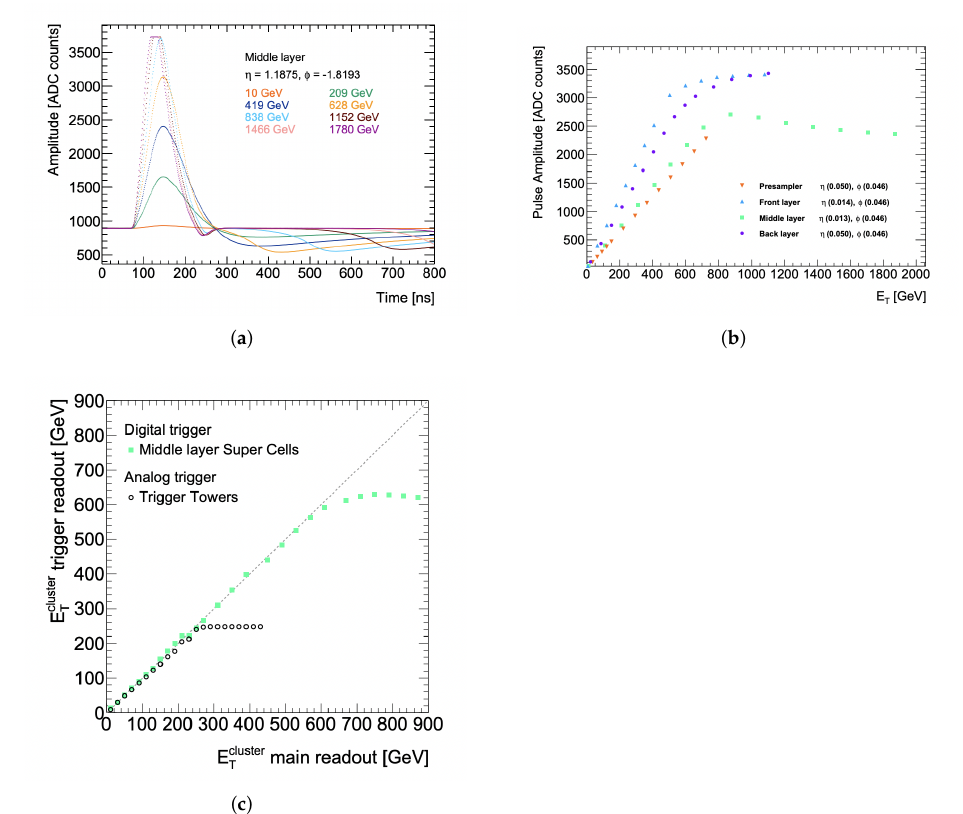
Figure 7. Pulse shape collected by the LATOME board for one SC in the barrel middle layer for several injected current pulses corresponding to different E T values ( a ), peak ADC value with respect to the pedestal as function of the E T corresponding to the injected pulse as seen on a LATOME board by four channels of the different calorimeter layers ( b ), comparison between the E T deposited in the middle layer SCs or TTs and the sum of the E T in the corresponding cells of the LAr barrel calorimeter ( c )